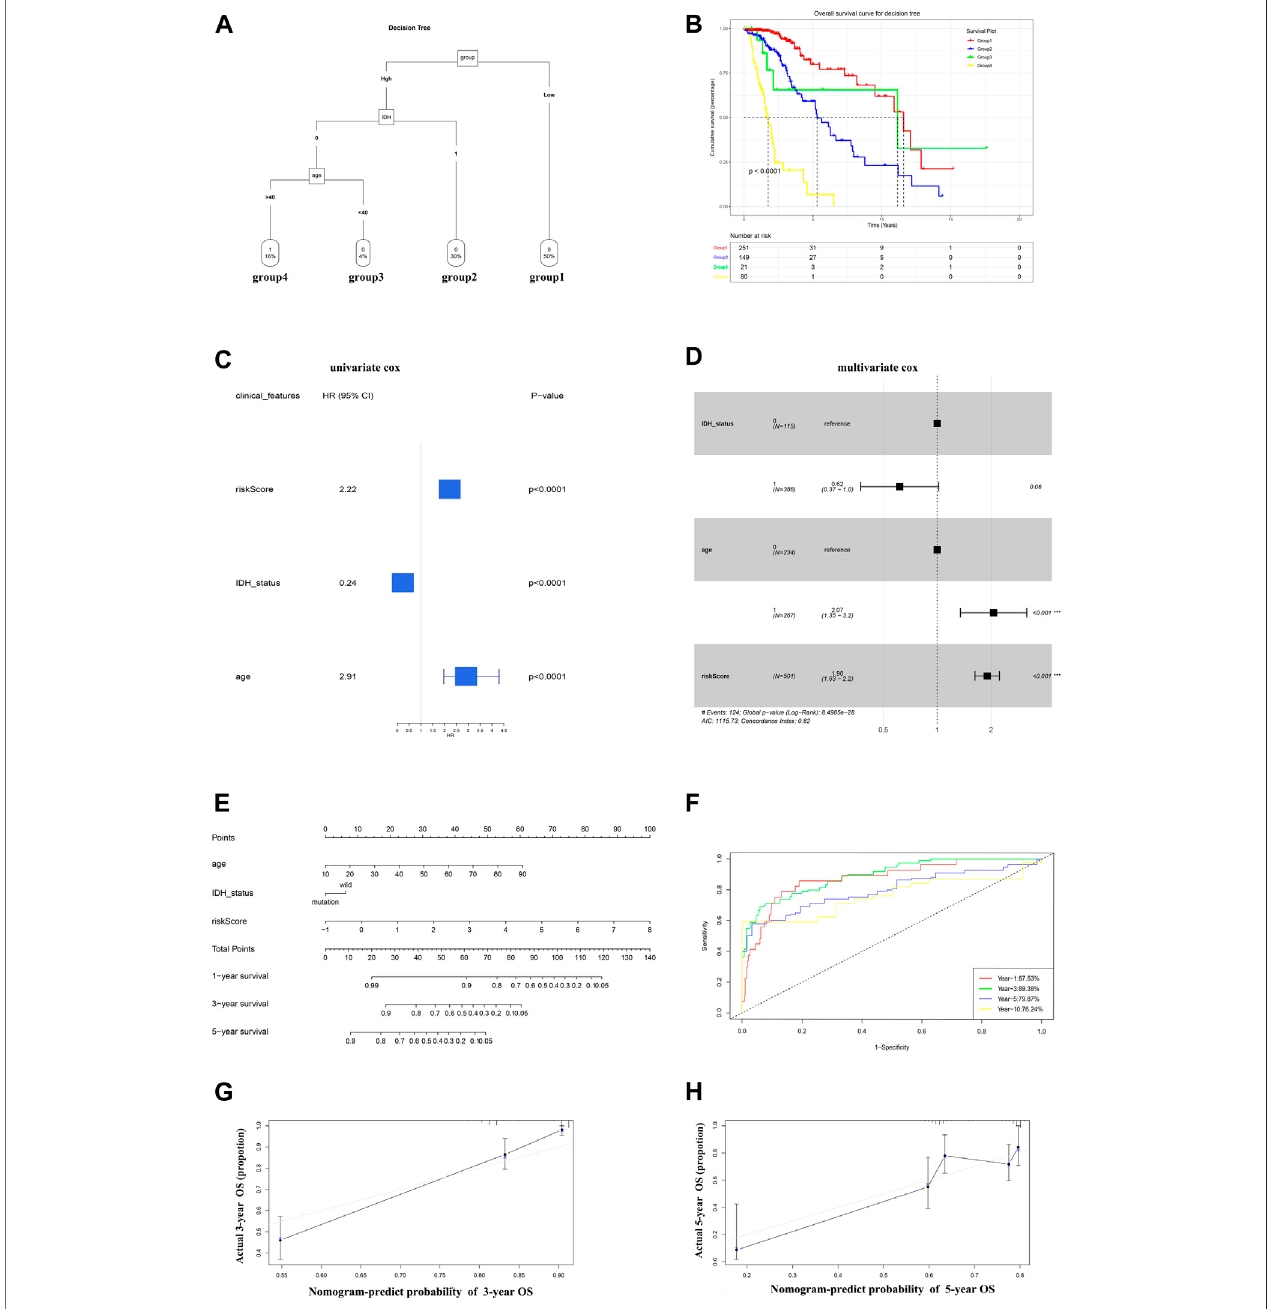
FIGURE 7 | A nomogram and decision tree constructed on the basis of glycolysis and clinicopathological features in TCGA. (A) The decision tree that was establishedtoincreasethelevelofriskstrati fi cation. (B) Kaplan-MeiercurvesshowingtheOSofsubgroupsestablishedusingthedecisiontree. (C-D) Univariatecox( p < 0.05) and Multivariate Cox ( p < 0.2) analysis of clinicopathological factors. (E) A nomogram was drawn to predict the survival rate at different time points for individual patients. (F) ROC curves at 1, 3, 5, and 10 years showing that the nomogram is a robust indicator for OS. (G-H) Three-year and 5-year calibration curves of the training